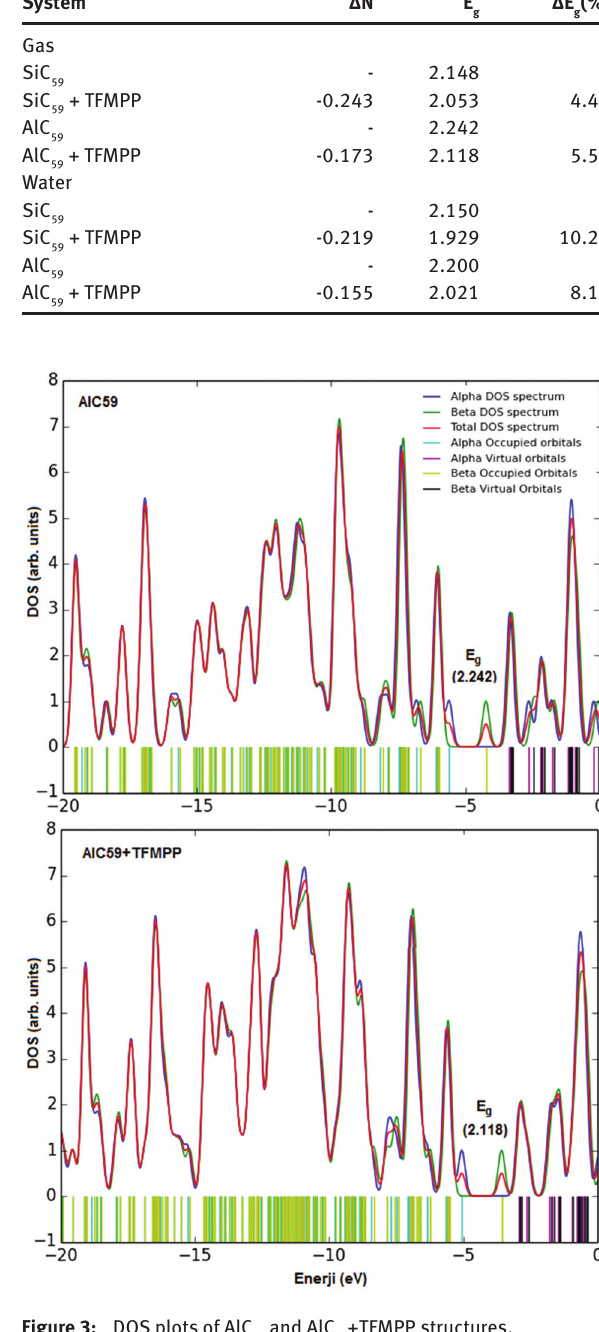
Figure 3: DOS plots of AlC